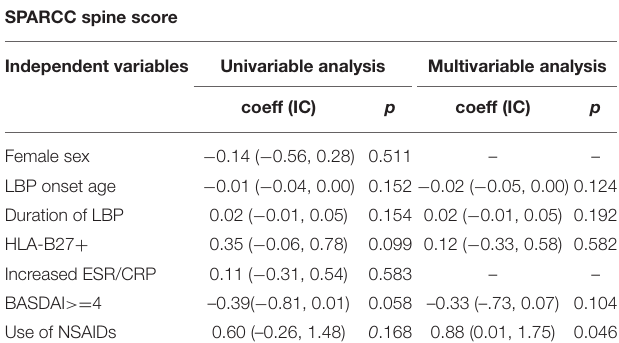
TABLE 4 | Baseline predictors factors of mSASSS score at T24. Independent variables